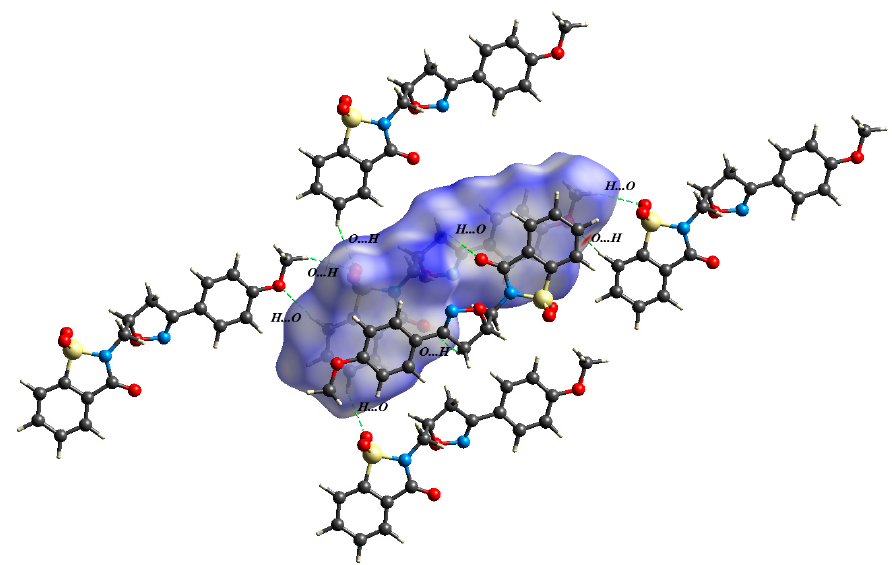
Figure 5. The main non-covalent interactions in the crystal packing.